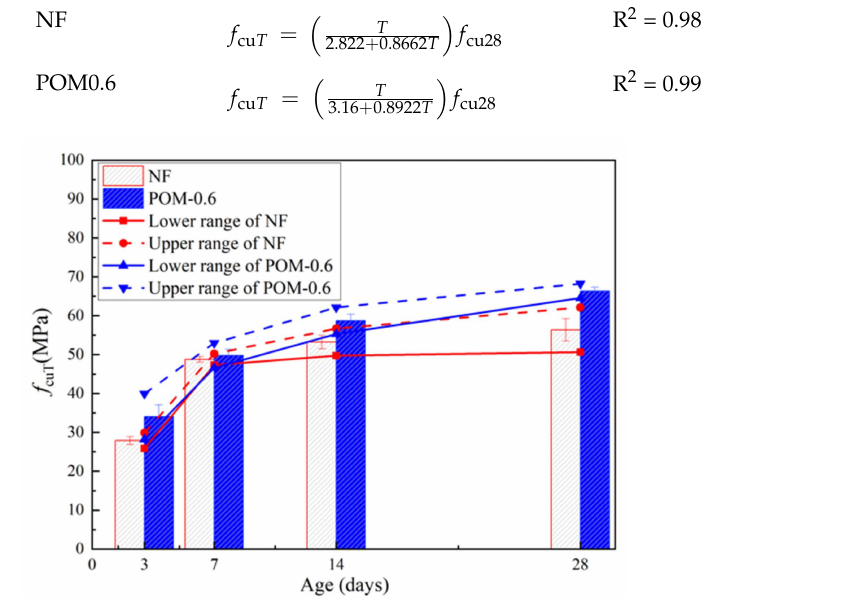
Figure 5. Test results of f cuT for NF and POM0.6 SWSSC specimens with different concrete ages.